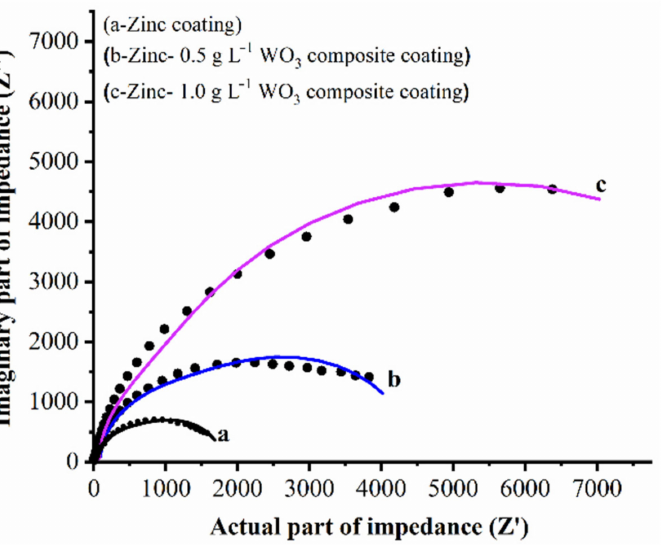
Figure 12. Impedance spectra of Zn and Zn–WO 3 composite coatings in 3.5% NaCl solution.